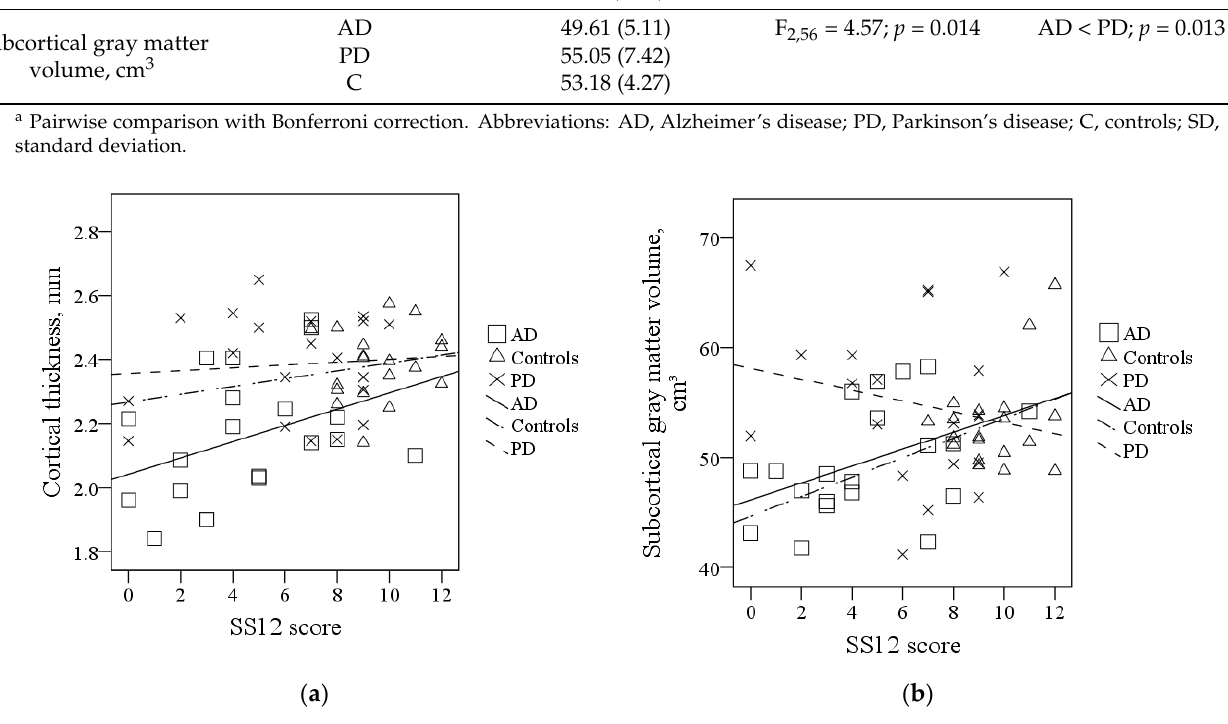
a Pairwise comparison with Bonferroni correction. Abbreviations : AD, Alzheimer’s disease; PD, Parkinson’s disease; C, controls; SD, standard deviation.